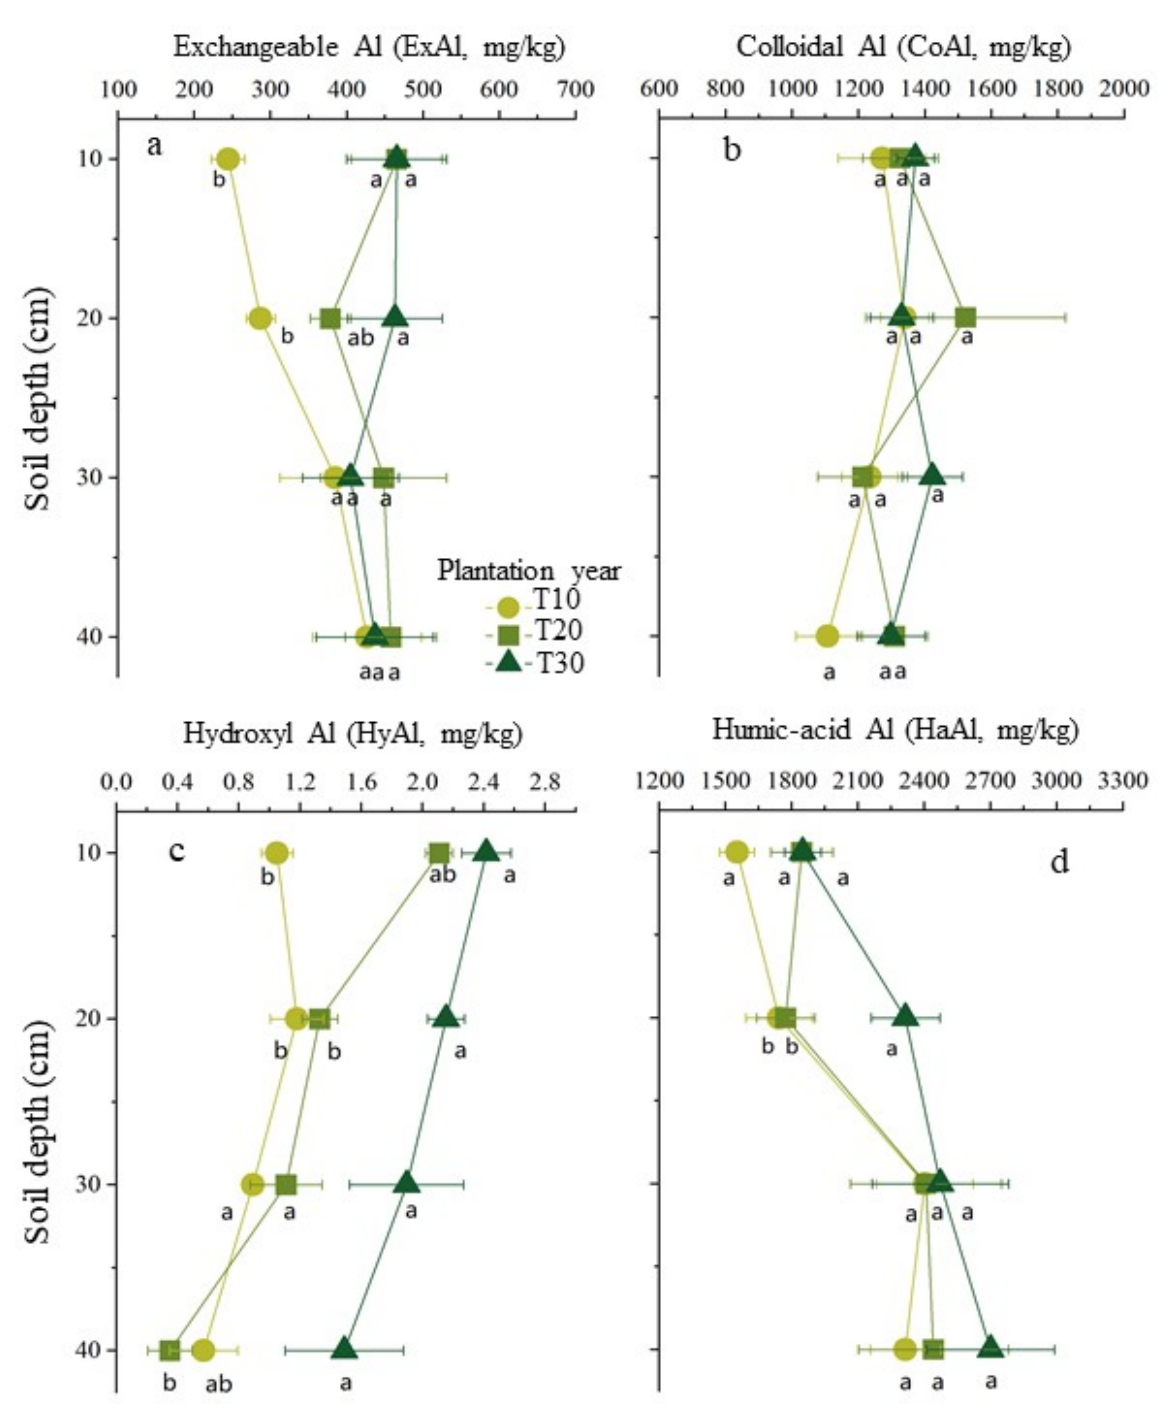
Figure 2. Temporal and spatial distribution of 4 main aluminum (Al) forms in soils around bayberry tree roots. The concentrations of aluminum (abscissa axis) in different soil depth (axis of ordinates) from sample soil of the different tree ages of T10 for 10 years old, T20 for 20 years old, and T30 for 30 years old were showed for exchangeable Al in ( a ), for colloidal Al in ( b ), for hydroxyl Al in ( c ), and for humic-acid Al in ( d ). The different letters represent significant differences in different tree age bayberry ( p < 0.05).